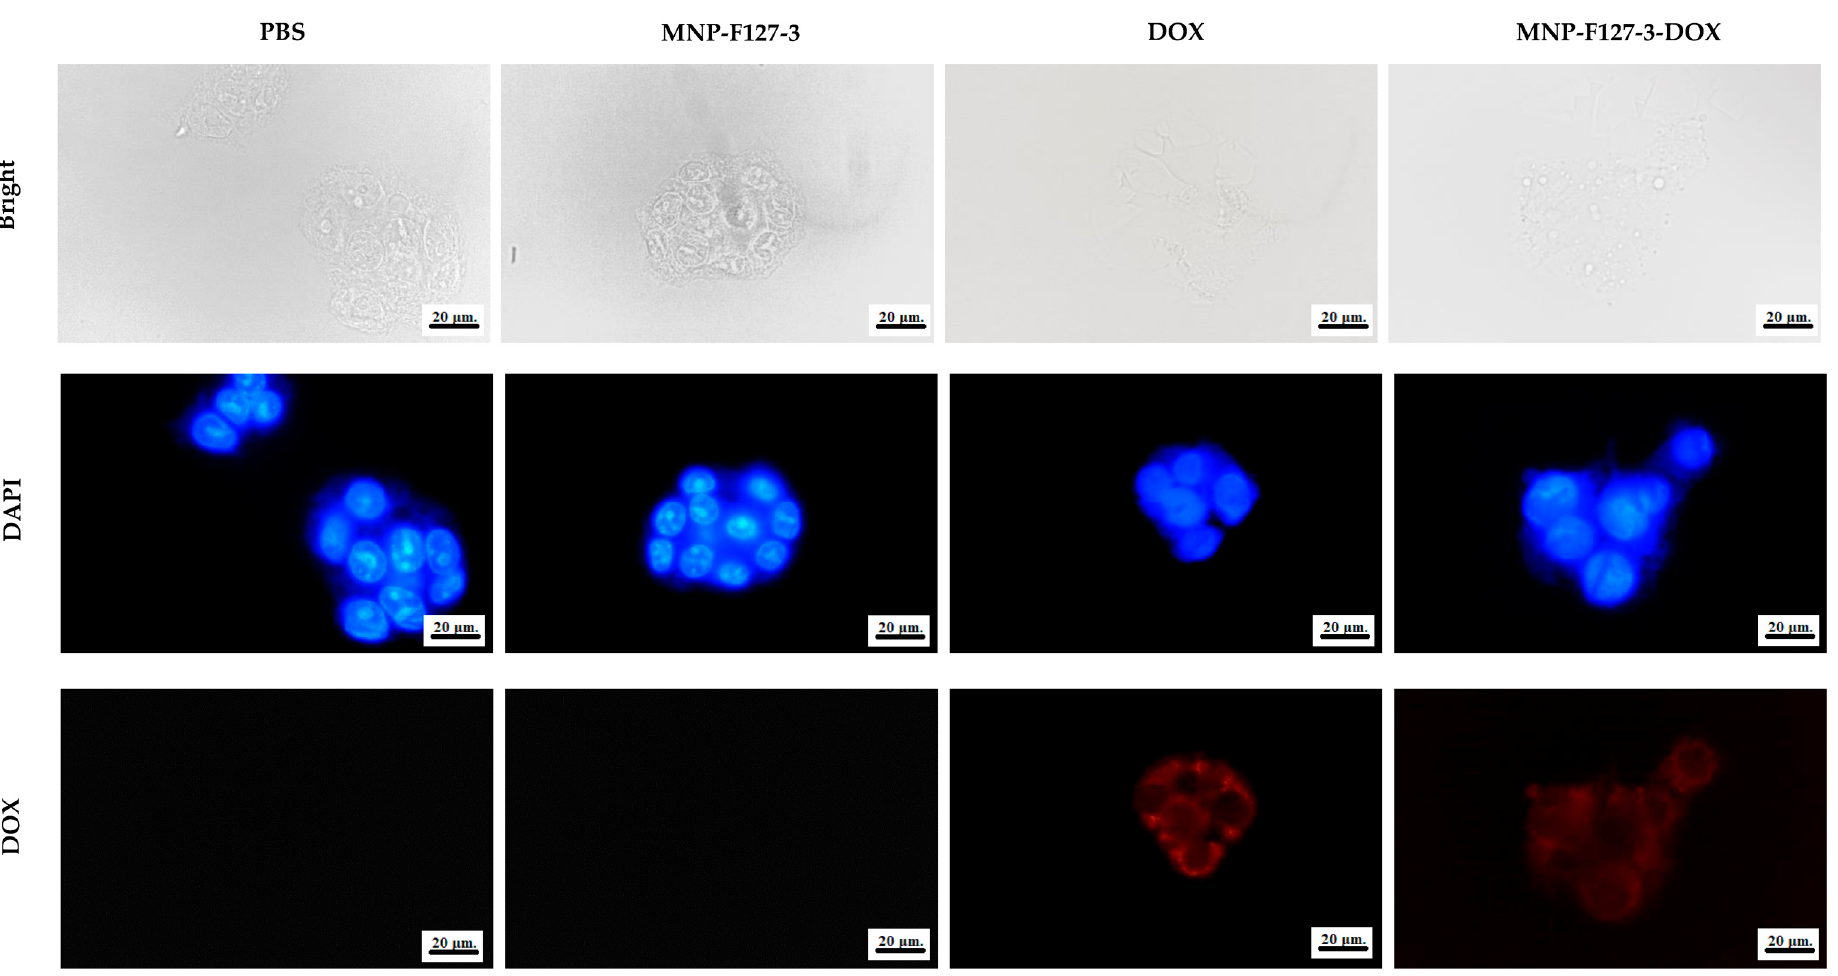
Figure 9. Cellular uptake of HepG2 cell lines treated with PBS, MNP-F127-3, free DOX, and MNP-F127-3-DOX.